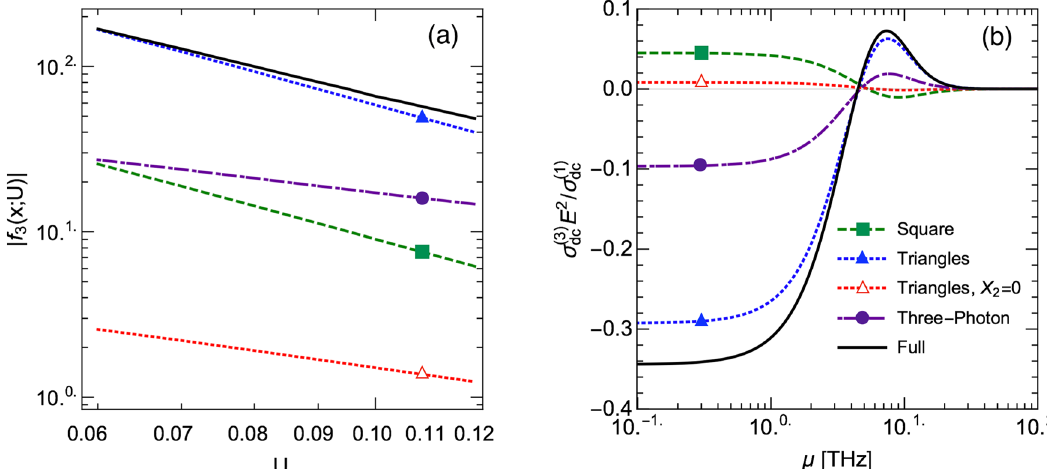
Fig. 3 Universal scaling of nonlinear dc conductivity in 2D Dirac materials. a Log – log scale plot for the absolute value of the characteristic third-order transport function f 3 ( μ , U ) versus U at x = 0.03. Different lines correspond to the individual contribution of diagrams in Fig. 1a as mentioned the shared plot-legend in ( b ). b Nonlinear correction g ¼ j σ ð 3 Þ chemical potential μ for U = 0.11. Similar to ( a ), different curves correspond to different diagram ’ s contribution as mentioned the